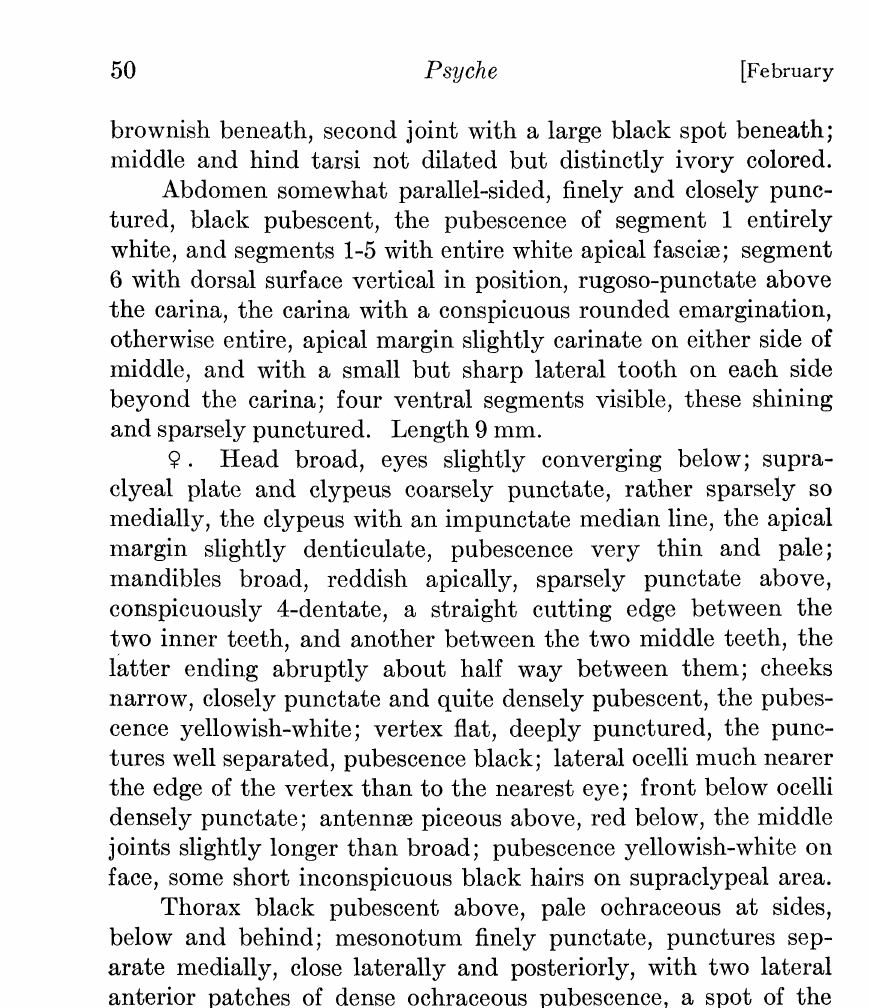
Psyche [February brownish beneath, second joint with a large black spot beneath; middle and hind tarsi not dilated but distinctly ivory